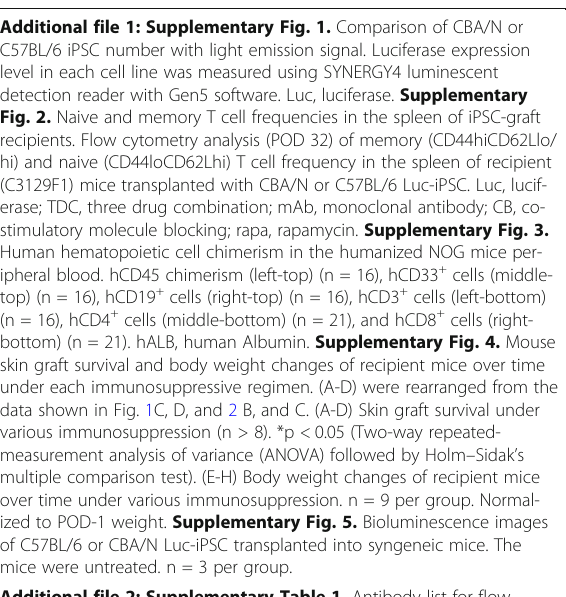
Additional file 2: Supplementary Table 1. Antibody list for flow cytometry Acknowledgements Not